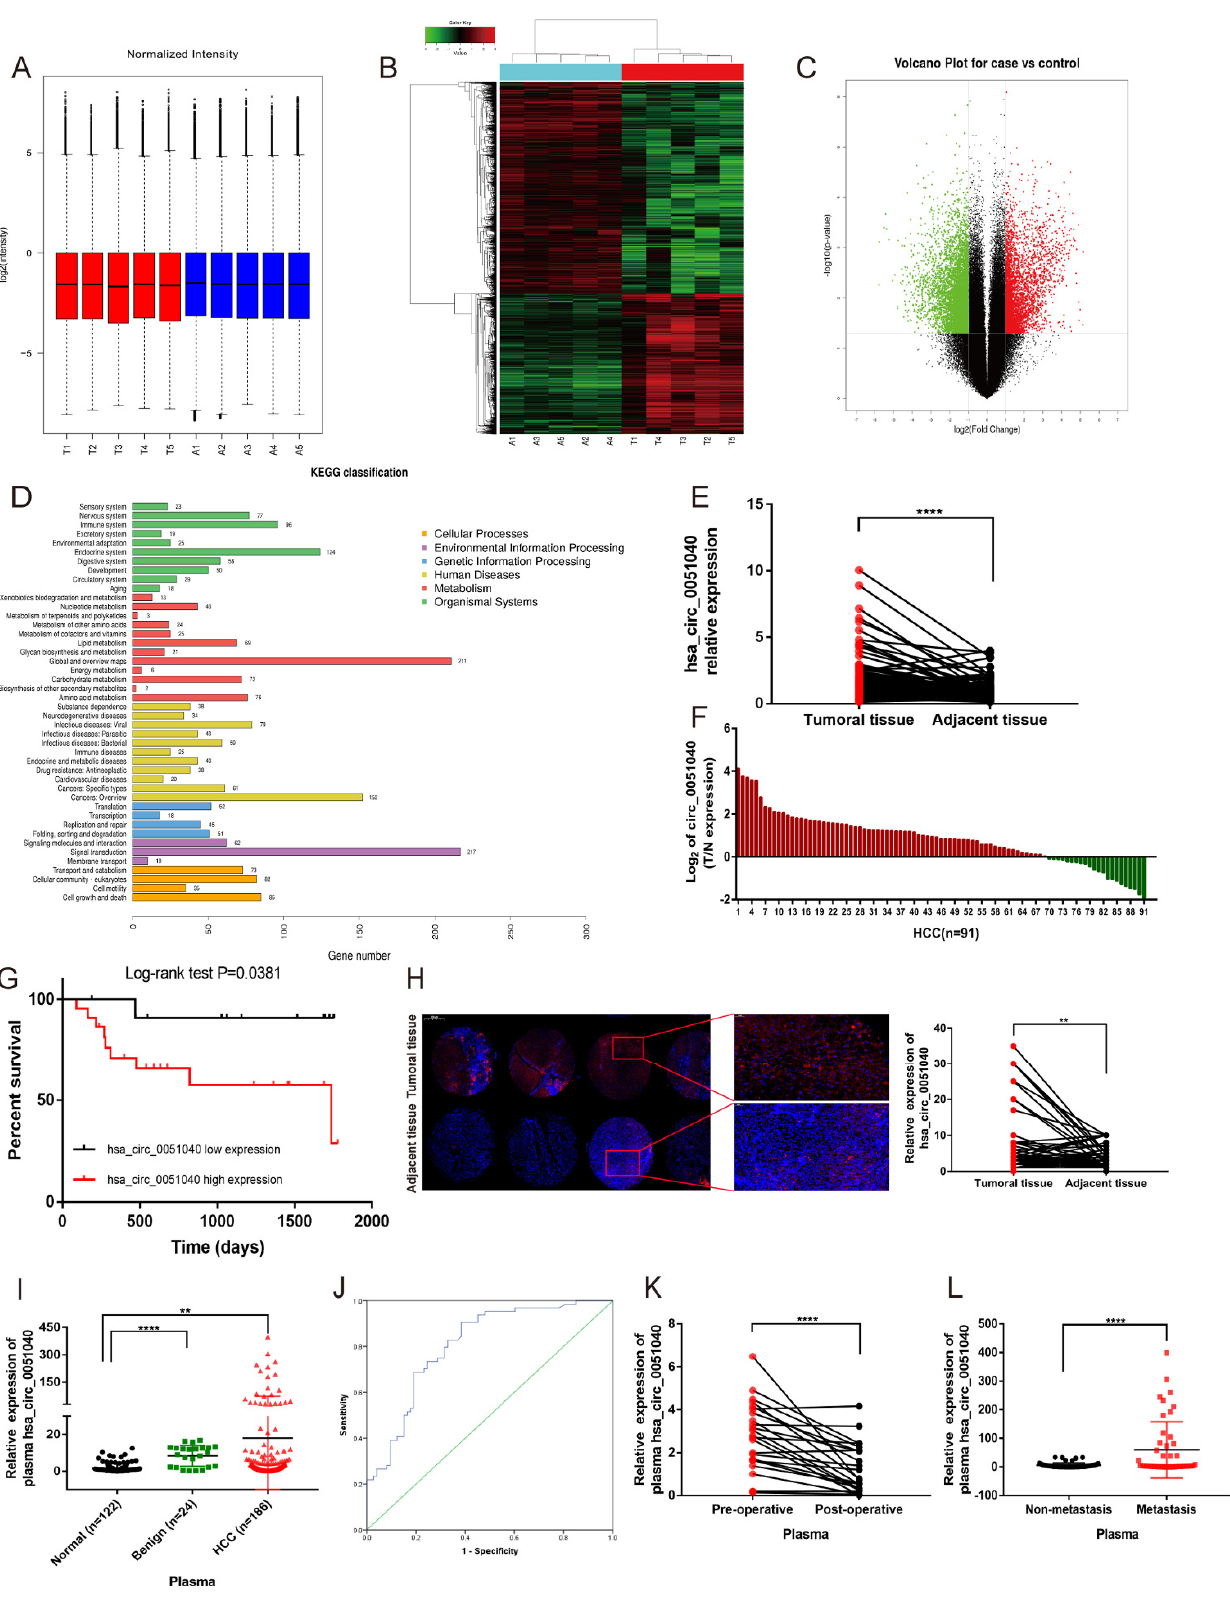
Figure 1. Upregulation of hsa_circ_0051040 in HCC. ( A ) Box plots showing that the distributions of circRNA profiles in both groups were nearly the same after normalization. HCC tissue samples: T1-T5; Adjacent normal tissue samples: A1–A5. ( B ) Heat map showing the upregulated and downreg- ulated circRNAs in five pairs of HCC tissues (T) and adjacent normal tissues (A). ( C ) Volcano plot showing the upregulated and downregulated circRNAs in five pairs of HCC and adjacent normal